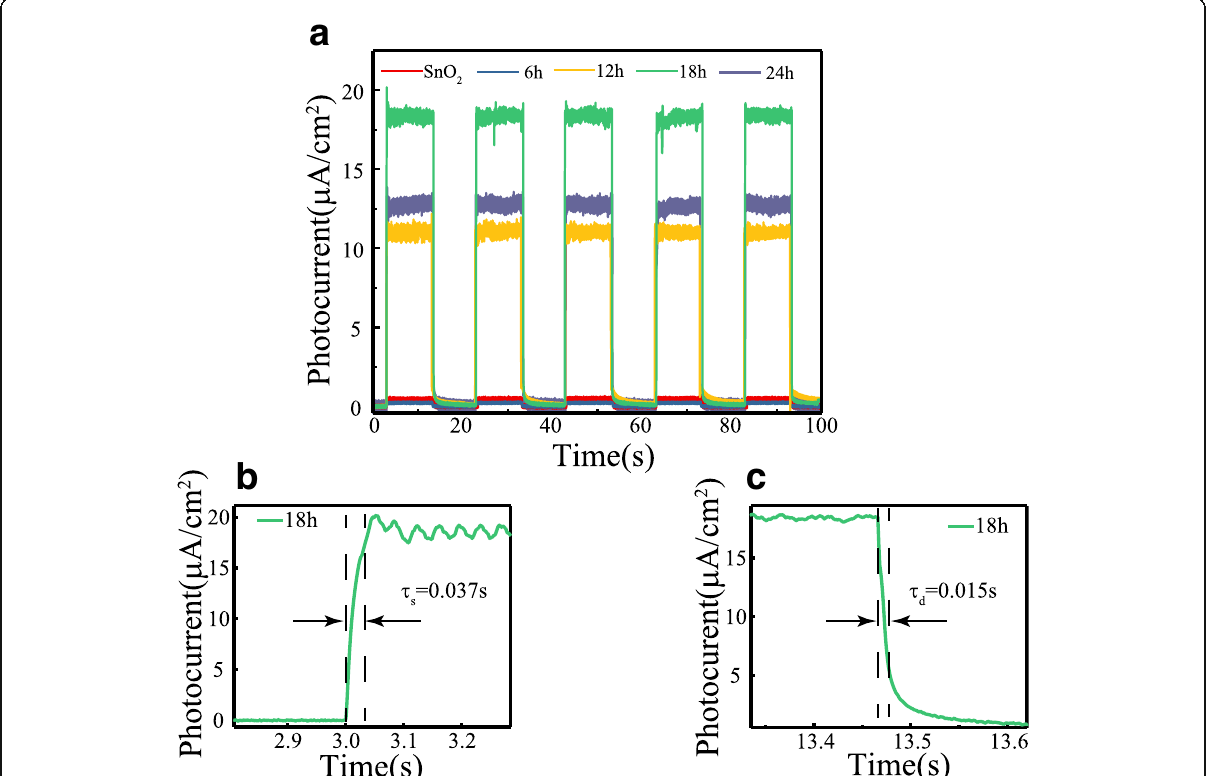
Fig. 4 Time response of the STNMAs/water UV detector. a Photocurrent response under on/off radiation of 129 μ W/cm 2 UV light illumination. b Enlarged rising and c decaying edge of the photocurrent